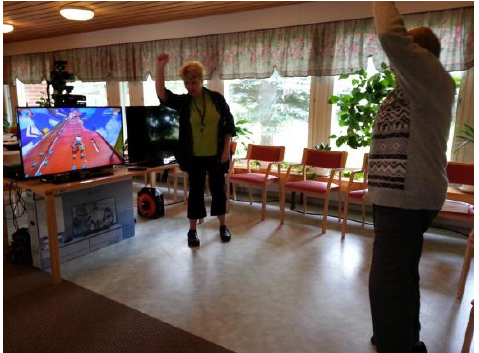
Figure 2. The usability testing of the commercial game.